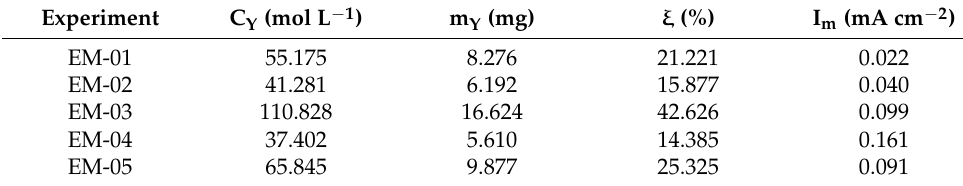
Table 3. EMS analysis